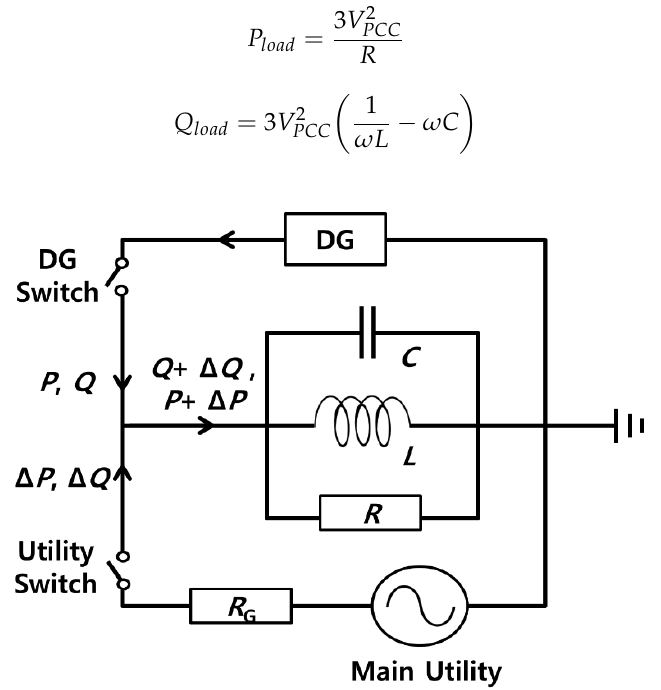
Figure 4. A generic system of islanding detection.